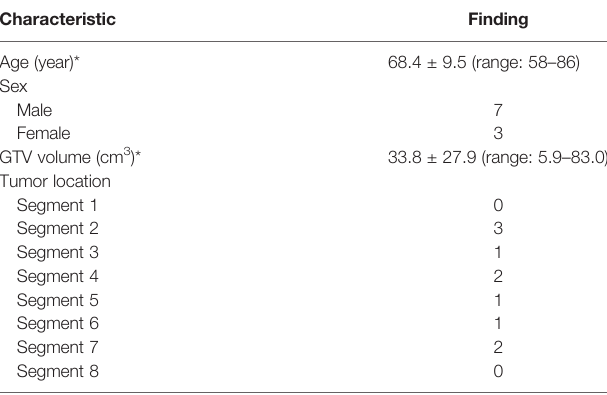
TABLE 1 | Characteristics of HCC patients enrolled in this study.